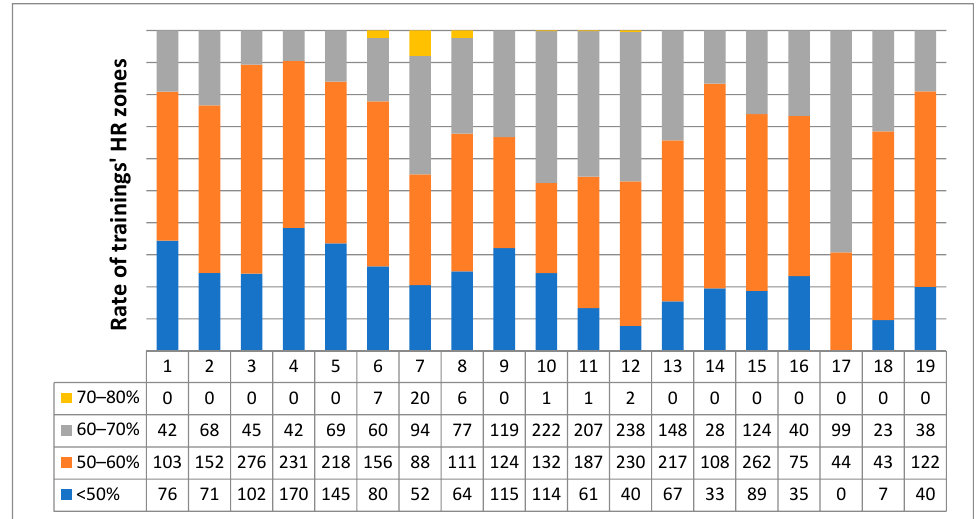
Figure 1. Trainings’ rate spent in different HR zones during second half of the program. Maximum HR (100%) was determined from the 220-age formula and intensity zones (here seen with different colors) were calculated from that HR for the patient. In the first row, numbers of the monitored weeks (1–19) are